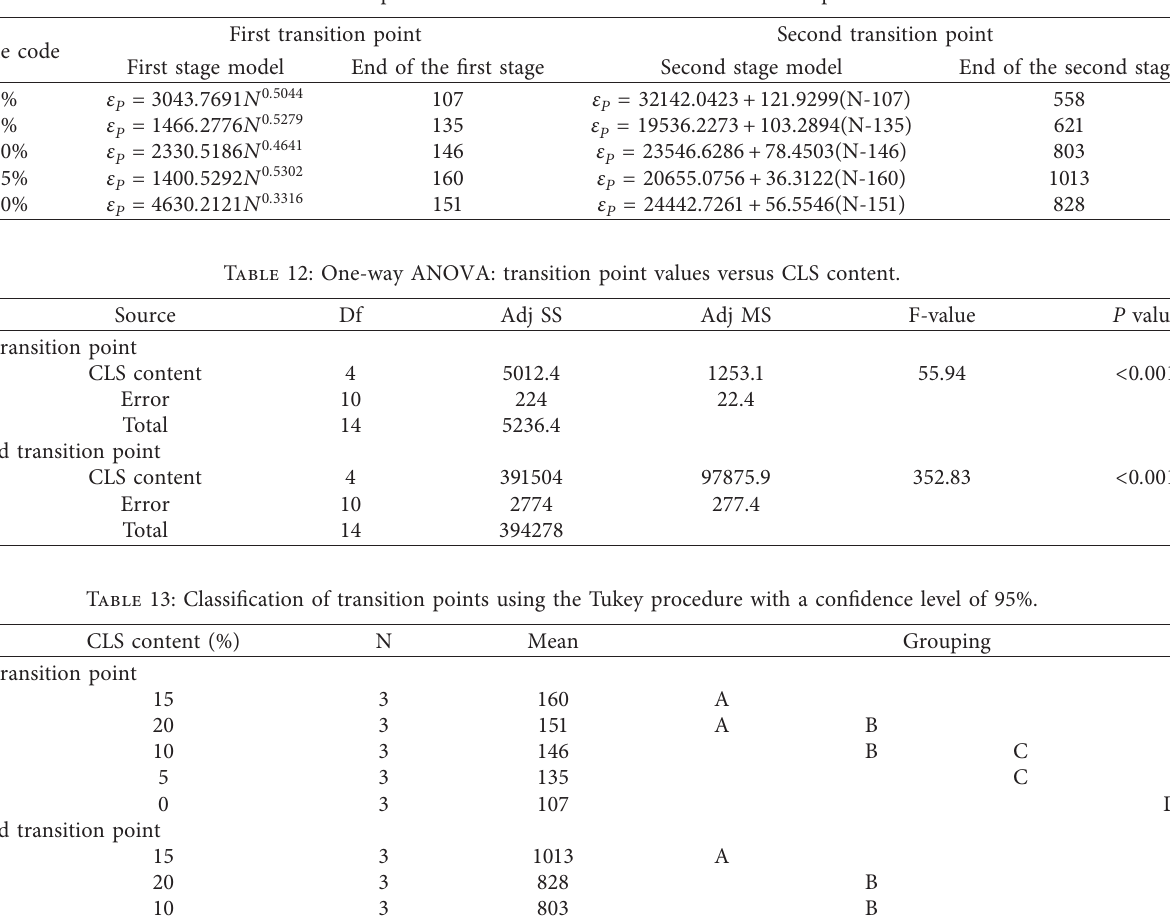
Table 11: Creep curve models derived from Zhou’s transition points.